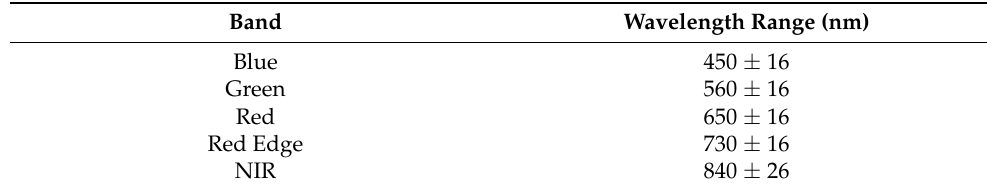
Figure 2. Instruments and ground control points (GCPs): ( a ) DJI P4 Multispectral UAV, ( b ) RTK S86 system, and ( c , d ) examples of the GCPs. Table 2. Coordinates of the ground control points (GCPs) measured using the RTK S86T system. Table 1. Spectral region and wavelength range of the UAV-derived multispectral